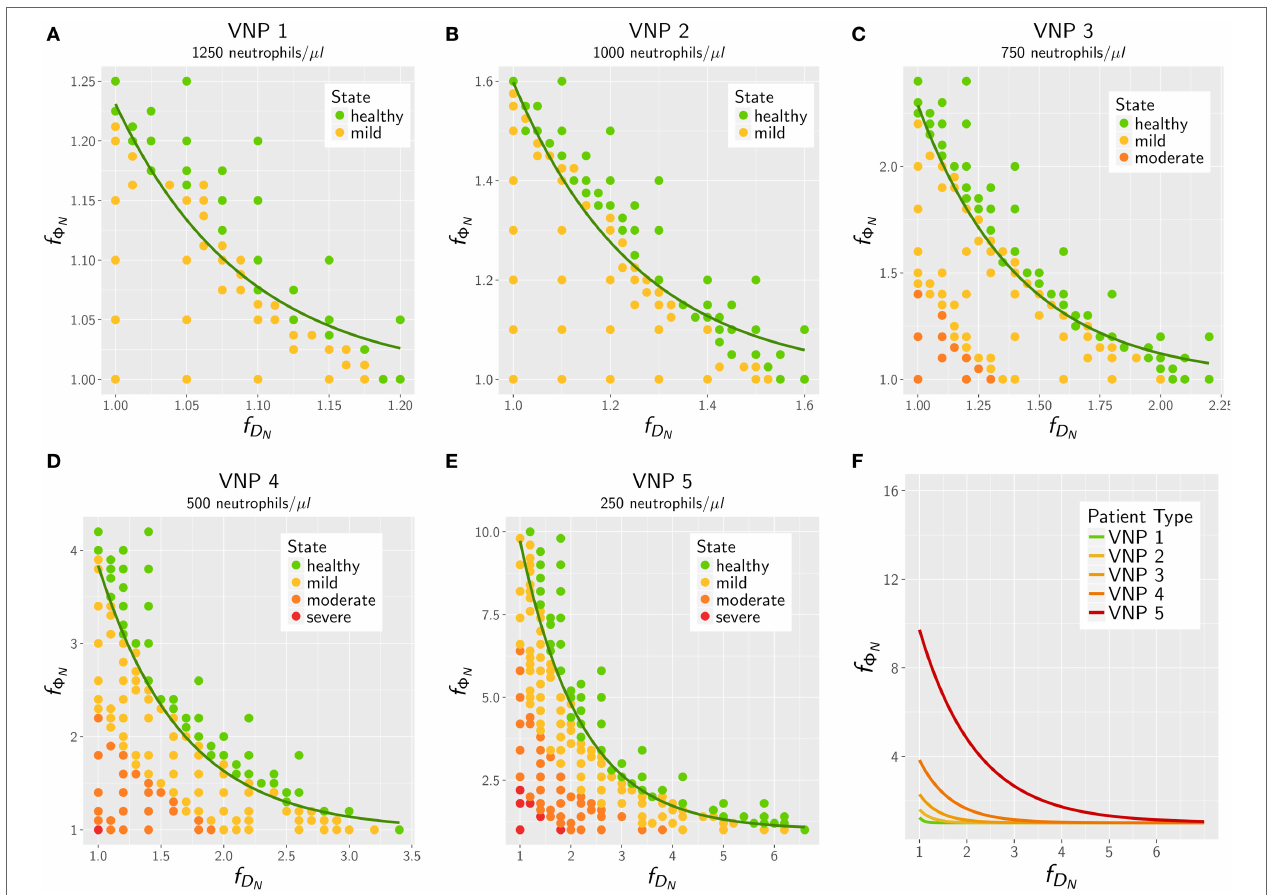
FIGURE 6 | In silico treatment of virtual neutropenic patients (VNP) infected with Candida albicans was simulated using the agent-based model. Stepwise increase of phagocytosis rate and diffusion coefficient of neutrophils was performed for VNP with various severity degrees of neutropenia: VNP1–5: 1,250 (A) , 1,000 (B) , 750 (C) , 500 (D) , and 250 (E) neutrophils/ μ l. Simulated points are classified according to the previously determined patterns: green points show a non-neutropenic infection outcome, yellow points show an infection outcome comparable to a mild neutropenia, orange points show an infection outcome comparable to a moderate neutropenia, and red points show an infection outcome comparable to a severe neutropenia. Solid lines depict the fitted exponential function f Φ at the transition to the non-neutropenic infection outcome. For comparison the fitted curves for the five VNP with their severity degrees of neutropenia are shown in panel (F)